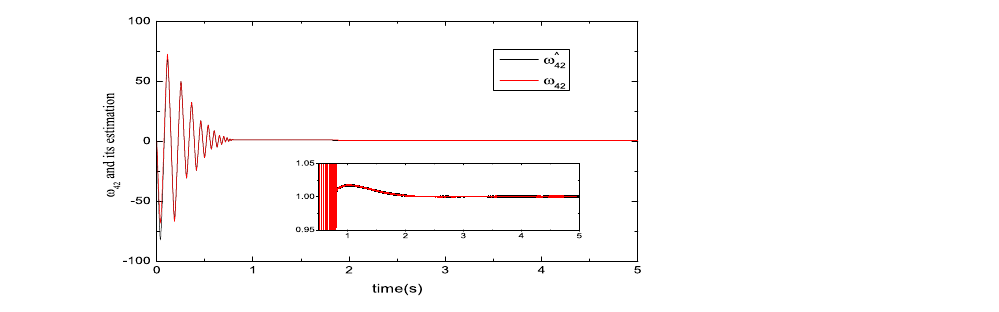
Figure 9. Estimated performance evaluation curves of four motor velocities: velocity ω 4 and its estimated value curve.